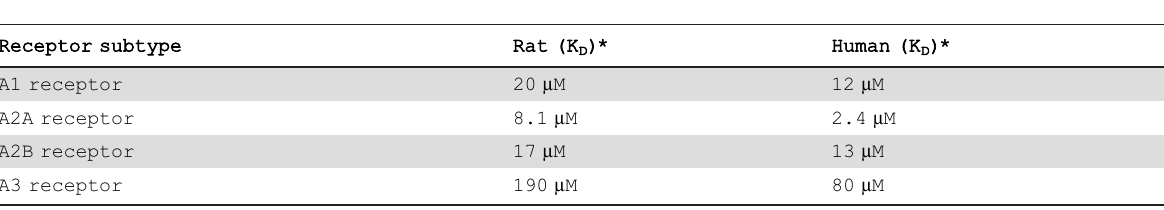
Table 2. Kd Values for caffeine antagonism on adenosine receptors.